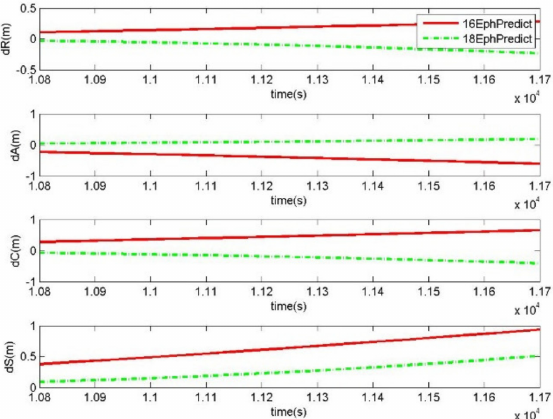
Figure 4. The prediction errors in 15 min after the 2 h validity period by the 18-parameter ephemeris and the 16-parameter ephemeris (18EphPredict and 16EphPredict) for satellite 3 starting from UTC 2017 / 07 / 05 00:00:00.